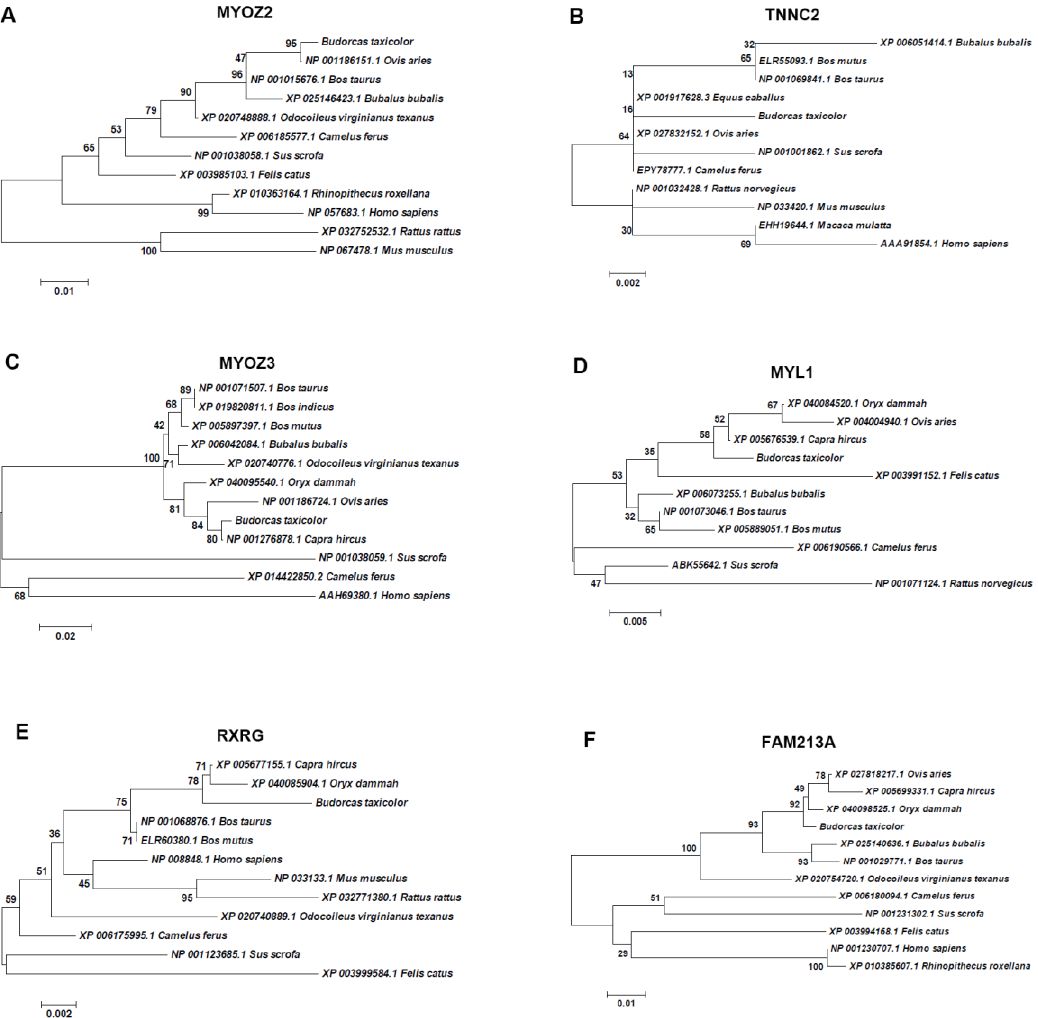
Figure 7. The phylogenetic analysis of assembled unigenes encoding. MYOZ2 ( A ), TNNC2 ( B ), MYOZ3 ( C ), MYL1 ( D ), RXRG ( E ) and FAM213A ( F ) were selected to construct phylogenetic trees. A statistical method used was neighbor-joining with a number of bootstrap replications of 1000. Branch numbers represent bootstrap values.